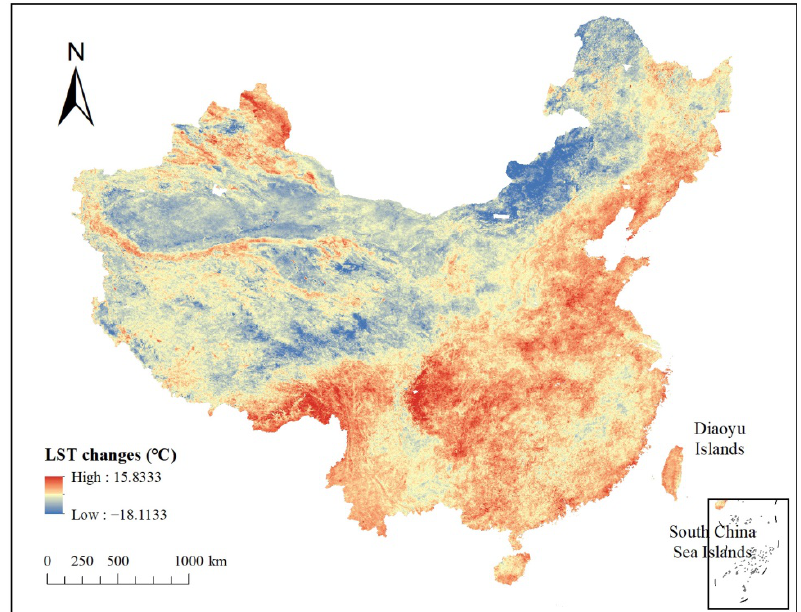
Figure A3. Distribution map of LST changes.